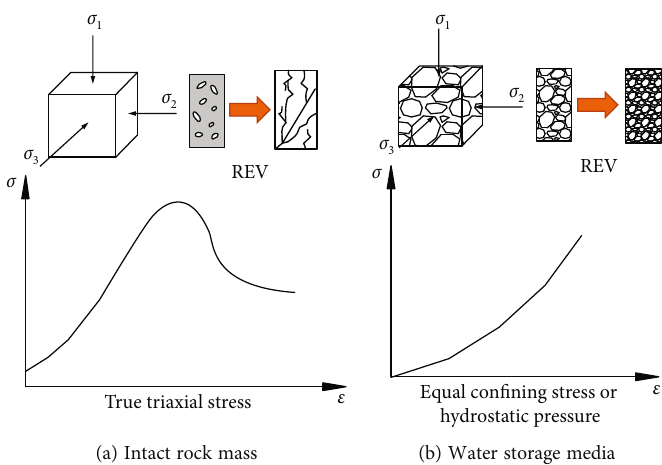
Figure 3: Stress-strain curves before and after the formation of the water storage media.